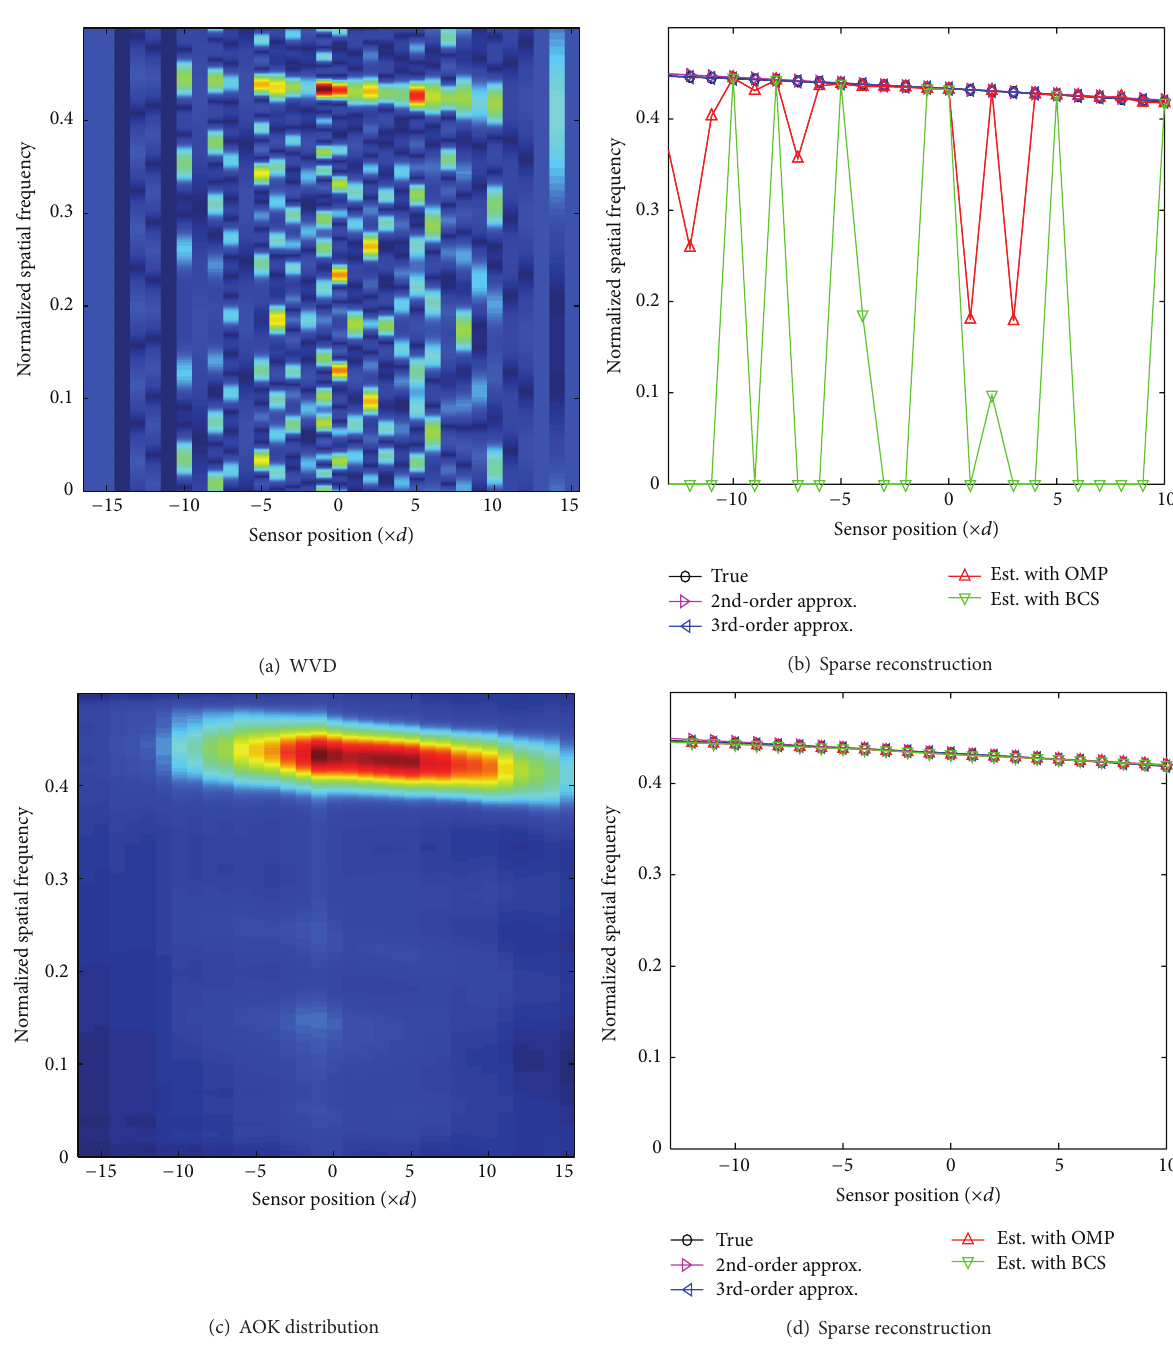
Figure 5: Near-field source location estimation using the sparse array ( 𝑟 1 = 1000 m, 𝜃 1 = 30 ∘ ).